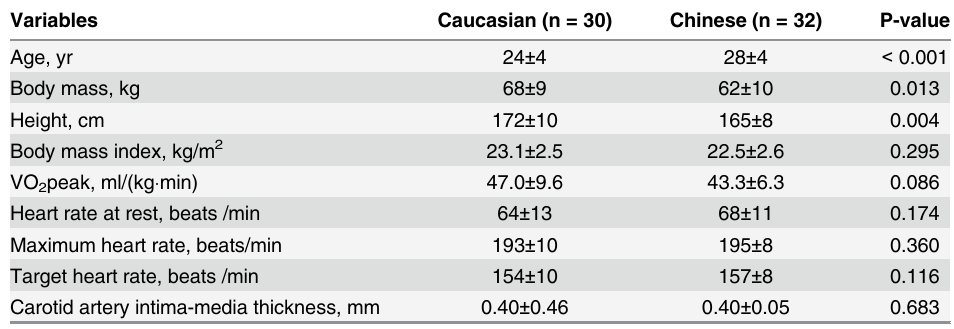
Table 1. Participants characteristics.